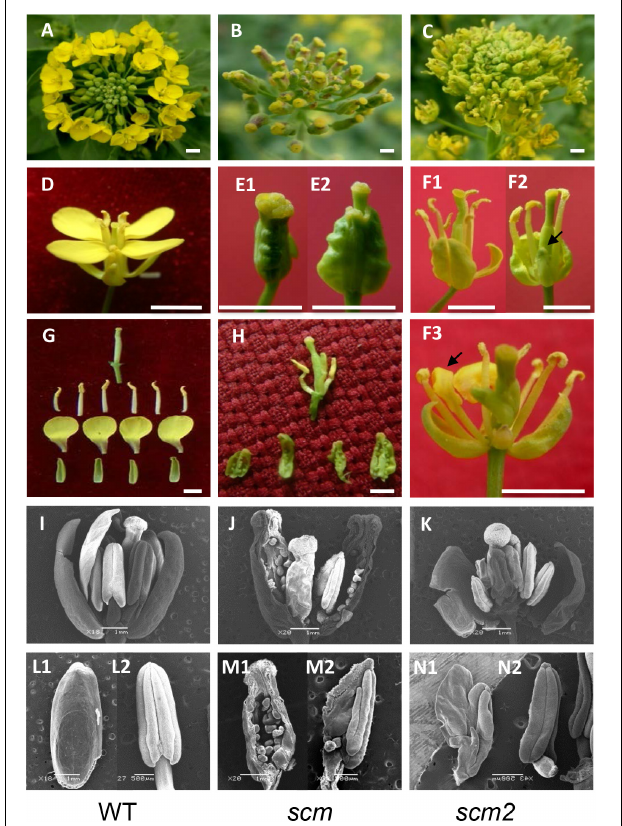
FIGURE 1 | Characteristics of the sepal carpeloid mutants of Brassica. (A–C) : inflorescence; (D , E1 , E2 , F1–F3) : flower; (G,H) : floral organs; (I–K) : SEM photos of flowers; (L1,L2,M1,M2,N1,N2) : SEM photos of floral organs; (A,D,G,I,L1,L2) : wild type Brassica (WT). (L1 , L2) Are sepal (left) and stamen (right); (B,E1,E2,H,J,M1,M2) : the typical sepal carpeloid mutant ( scm ). M1 is a sepal carpeloid organ, and M2 is an incomplete stamen to carpel organ with one ovule; (C,F1–F3,K,N1,N2) : the incomplete sepal carpeloid mutant ( scm2 ). Arrows indicate sepal carpel-like transition in F2 and petal stamen-like transition in F3 . N1 is an incomplete petal to stamen organ, and N2 is a stamen of scm 2. Bars in E1 and E2 are 5 mm; bars in I–K,L1,M1 are 1 mm; bars in L2,M2,N1,N2 are 500 µ m; and bars in the others are 10